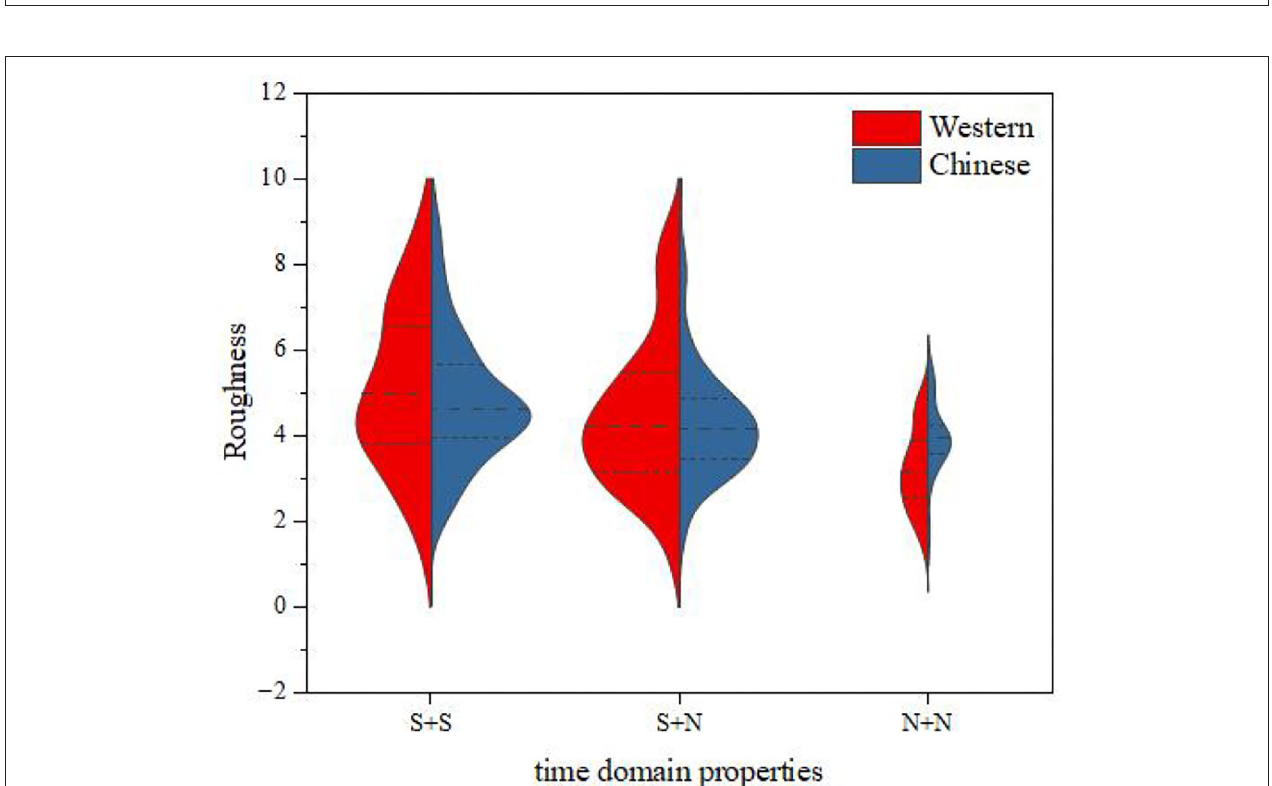
FIGURE 13 | Roughness comparisons between Western and Chinese